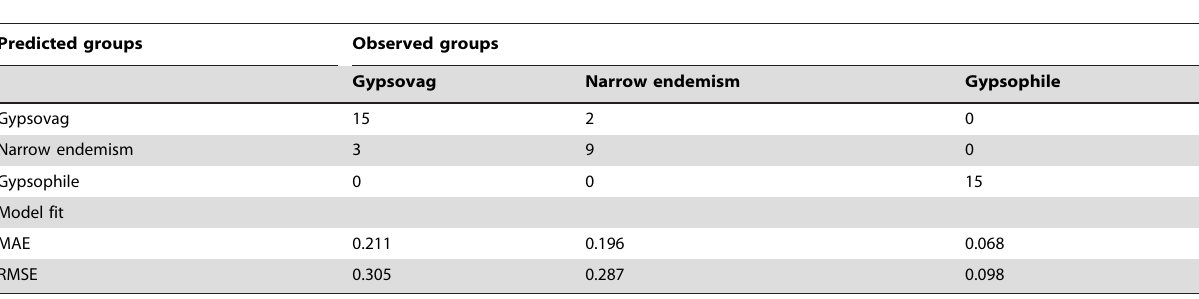
Table 5. Confusion matrix of plant types, based on neural network model prediction.